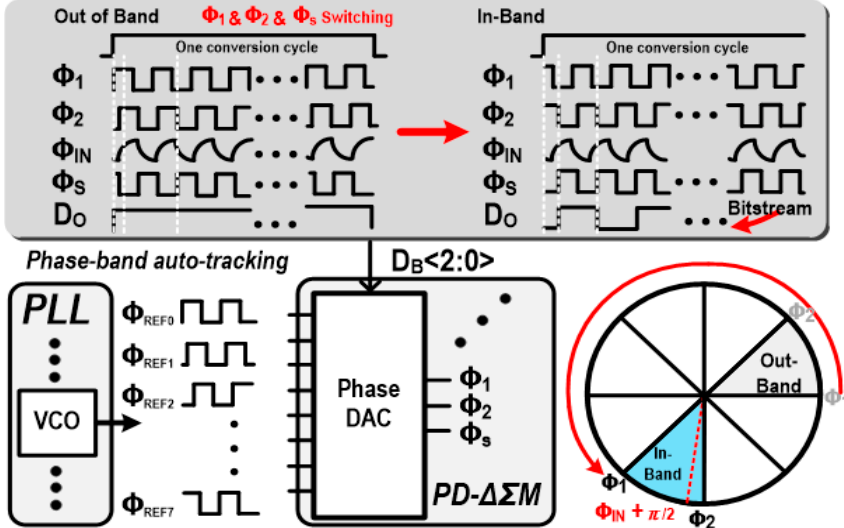
Figure 4. Operational principle of phase-band auto-tracking scheme.